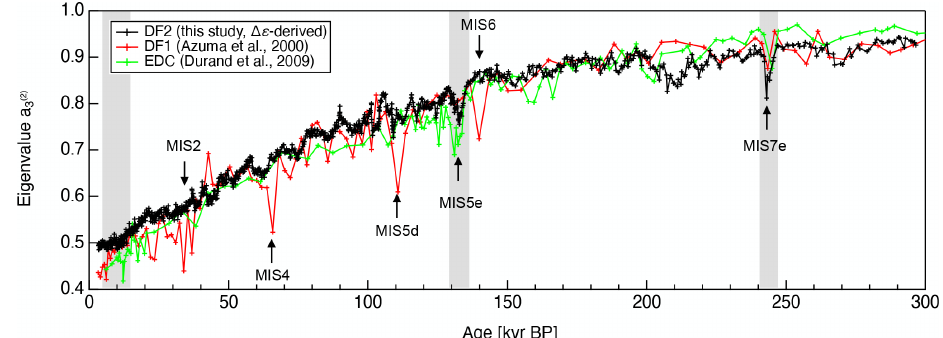
Figure 8. Comparisons of a ( 2 ) eigenvalues between the DF2 ice core (thick-section-based data), DF1 ice core (thin-section-based data) and 3 EDC ice core (thin-section-based). The DF1 and EDC data are from Azuma et al. (2000) and Durand et al. (2009), respectively. Arrows indicate MIS events noted by Durand et al. (2007). Gray shading indicates interglacial to glacial transitions. A common age scale referred to as DFO2006 was applied (Dome Fuji Ice Core Project Members, 2017).